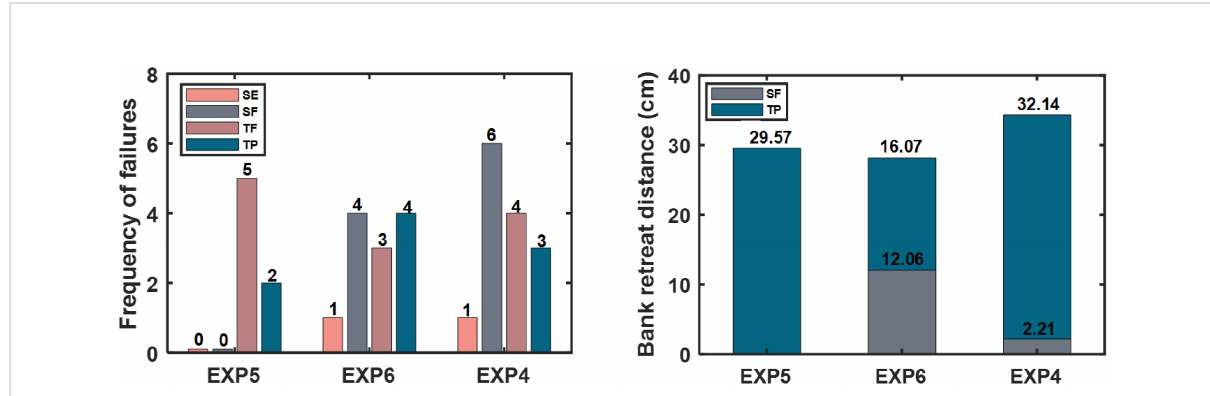
FIGURE 9 Frequency and contribution to bank retreat of each type of failures in 3D experiments. SE, seepage erosion; SF, shear failure; TF, tensile failure; TP, toppling